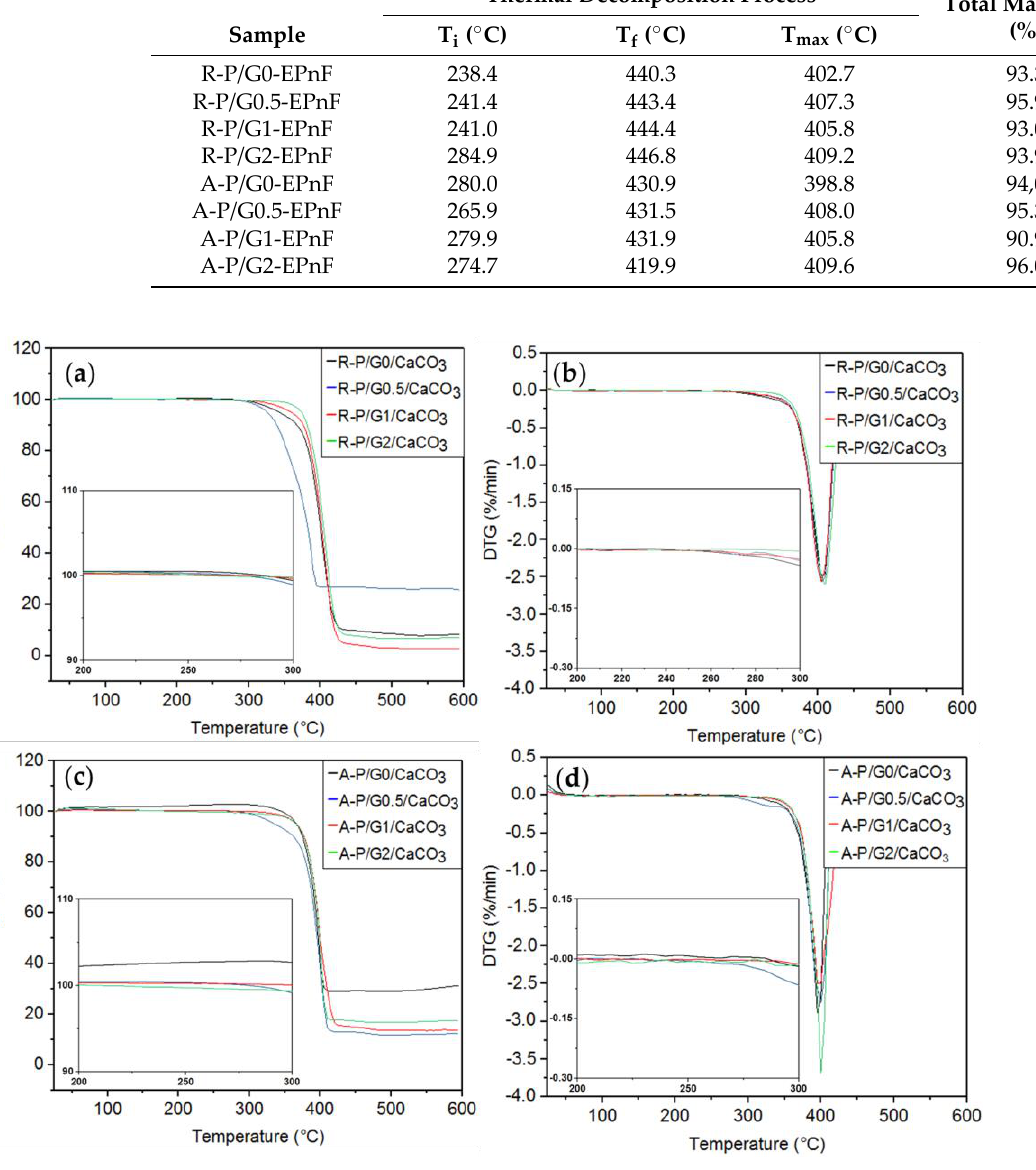
Figure 13. TGA and DTG curves for the R-P/G/CaCO 3 -EPnF and A-P/G/CaCO 3 -EPnF hybrid meshes. ( a ) TGA of R-P/G/CaCO 3 -EPnF, ( b ) DTG of R-P/G/CaCO 3 -EPnF meshes, ( c ) TGA of A- P/G/CaCO 3 -EPnF meshes, and ( d ) DTG of A-P/G/CaCO 3 -EPnF meshes.